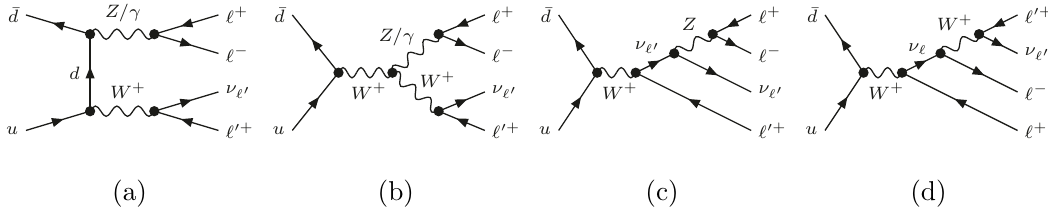
Figure 1 . Sample of Born diagrams contributing to W + Z production both in the di(cid:11)erent-(cid:13)avour channel ( ‘ = ‘ 0 ) and in the same-(cid:13)avour channel ( ‘ = ‘ 0 ). The analogous diagrams for W (cid:0) Z 6 production are achieved by charge